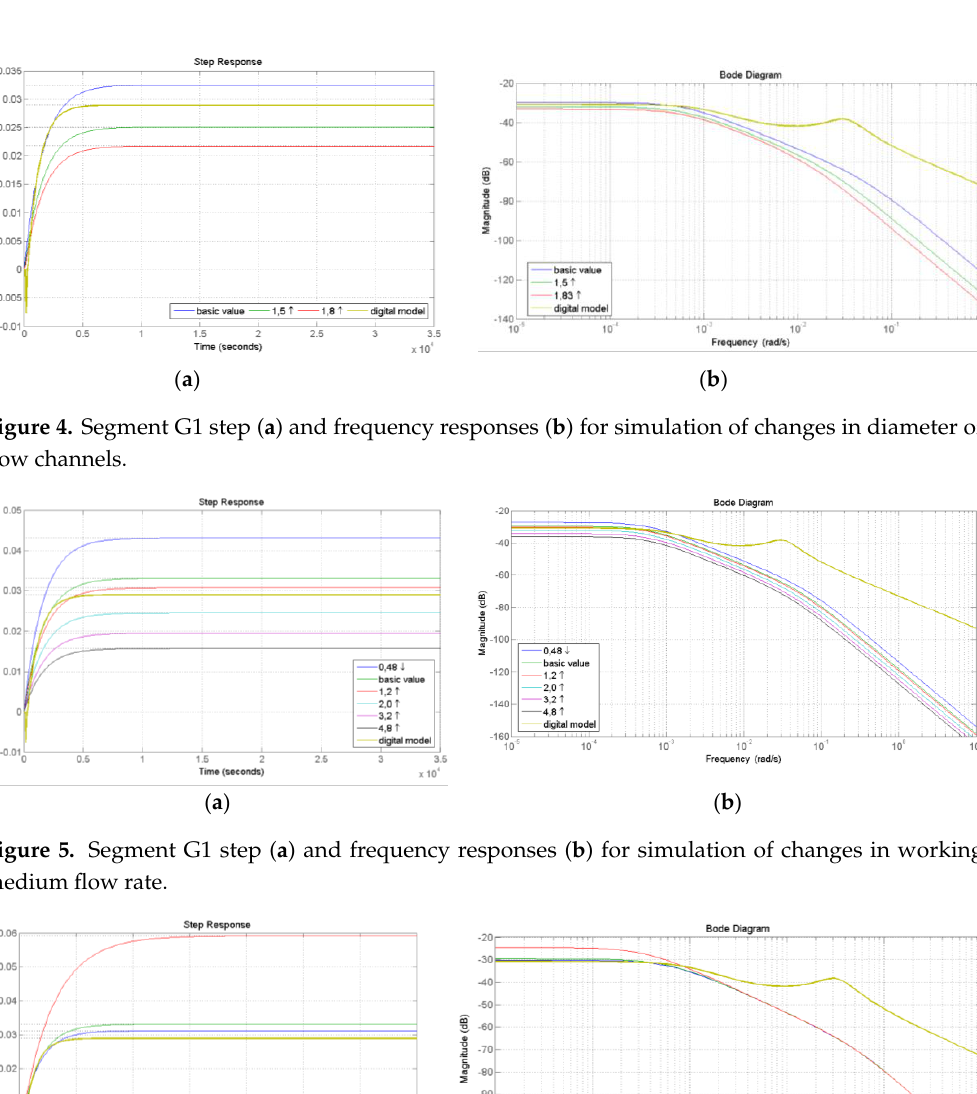
Figure 6. Segment G1 step ( a ) and frequency responses ( b ) for simulation of changes in ambient temperature.